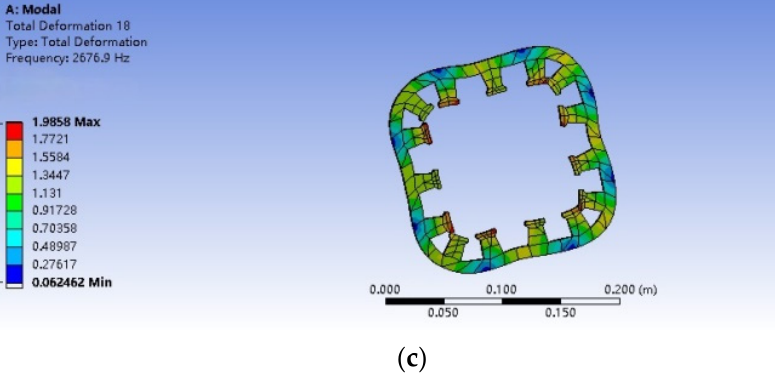
Figure 10. Electromagnetic stator modes: ( a ) second-order mode; ( b ) third-order mode; and ( c ) fourth-order mode.